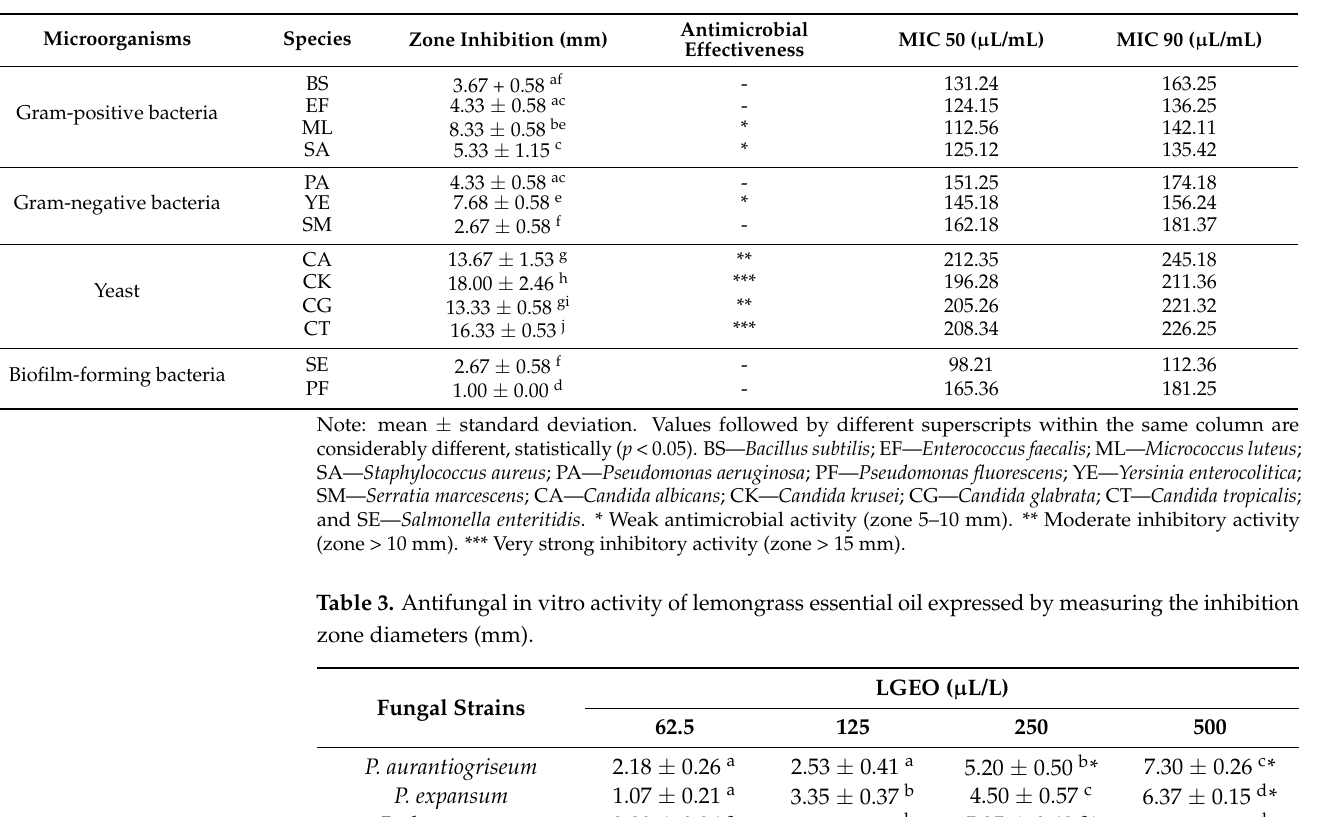
Table 2. Antimicrobial in vitro activity of lemongrass essential oil.